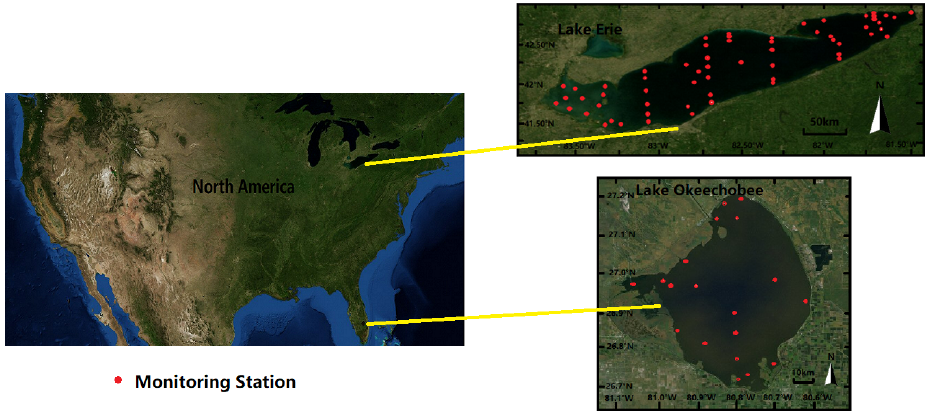
Figure 1. Spatial locations and monitoring stations of Lake Okeechobee and Lake